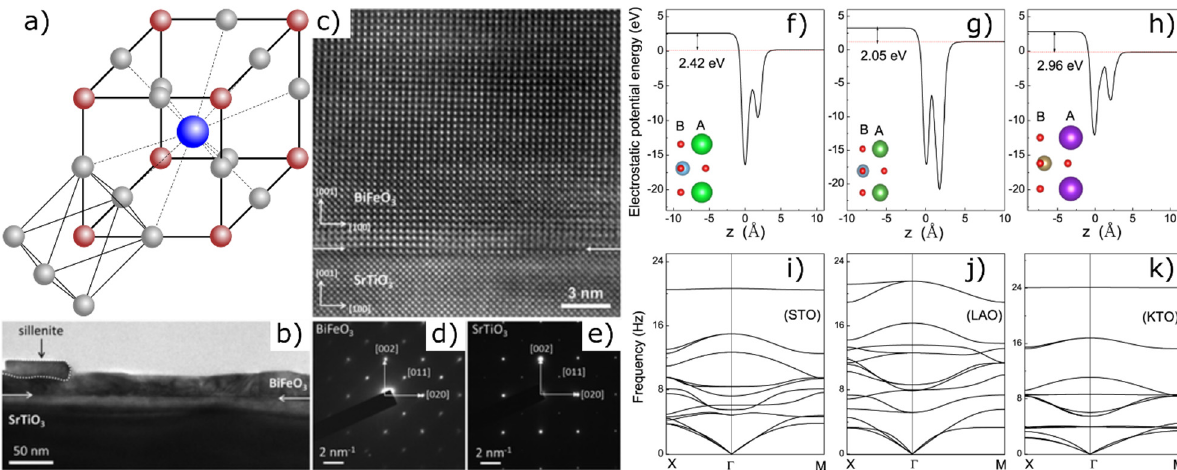
Figure 2. ( a ) Unit cell of perovskite ABO 3 (A: blue, B: red, O: grey). ( b ) Low-magnification transmission electron microscopy (TEM) image of a BiFeO 3 thin film grown on (001)-oriented SrTiO 3 . ( c ) Fourier-filtered TEM image of the interface between BiFeO 3 and SrTiO 3 showing no misfit dislocations. ( d , e ) SAED patterns of the BiFeO 3 film. Reprinted with permission from Akbashev et al. [100]. Copyright 2021 American Chemical Society. ( f – h ) Intrinsic average electrostatic potentials with optimized atomic structure and ( i – k ) phonon dispersion spectra of the three monolayers SrTiO 3 (STO), LaAlO 3 (LAO) and KTaO 3 (KTO), studied by the first-principles method [105]. © IOP Publishing. Reproduced with permission. All rights reserved.